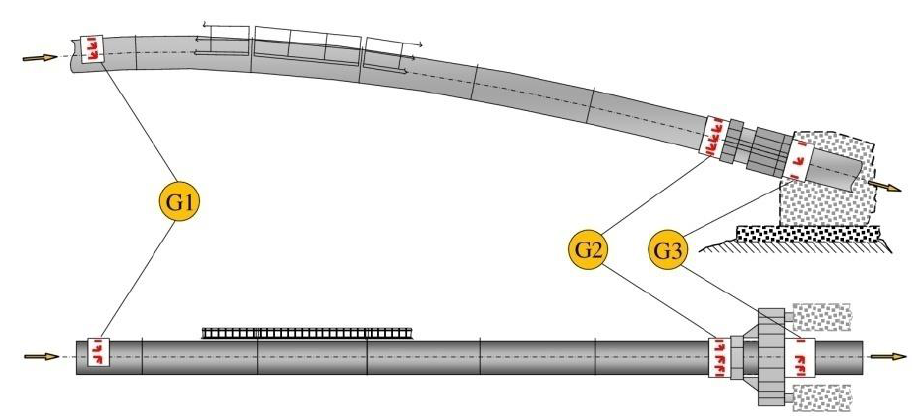
Figure 6. Scheme of the placement of strain gauges on pipes in three groups, G1 to G3.